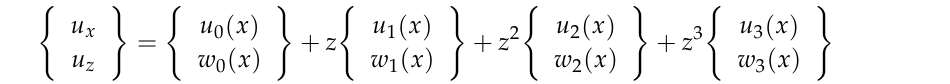
Table 1. Volume fraction of CNTs as a function of thickness coordinate for various cases of CNTs distribution [22].